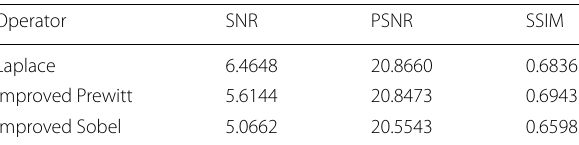
Table 3 Evaluation results of three operators for detecting co-frequency